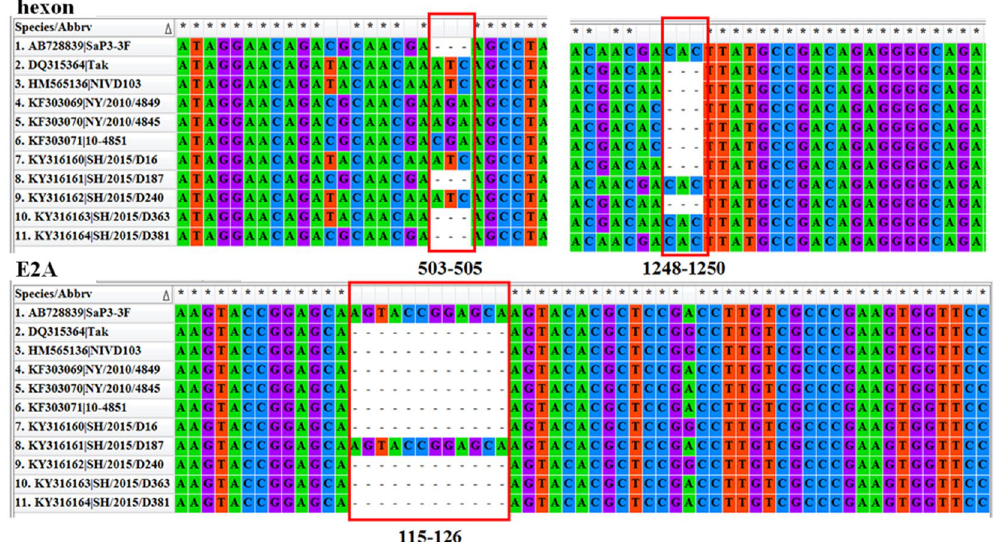
Figure 1. Comparative analysis of the hexon and E2A genes. Sequences of genes were aligned and visualized using MEGA6. Position of InDels compared to the reference genome NIVD103 are indicated in the